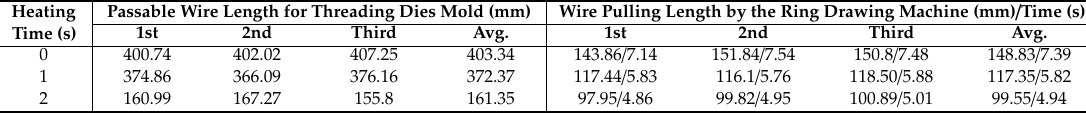
Table 22. Results based on wire pulling speed: k11(20.15 mm /